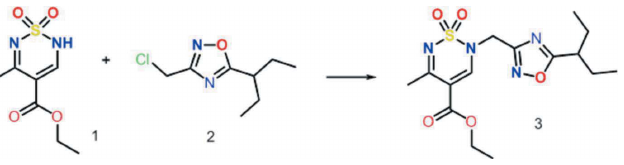
Figure 1 Synthesis of 2 H -1,2,6-thiadiazine 1,1-dioxide via intermolecular cycliza- tion of sulfamide with the corresponding 1,3-diketone.